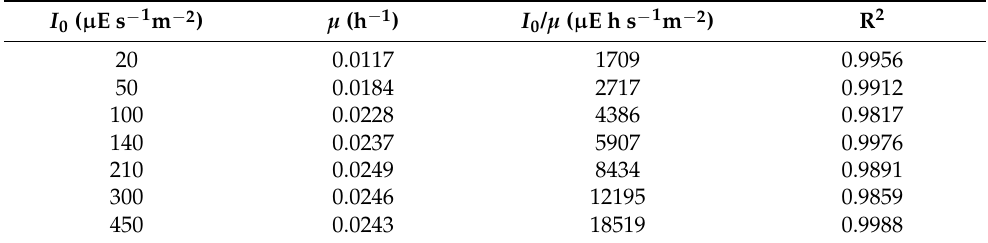
Table 1. Values of specific growth rates and R 2 calculated at different light intensities at T = 25 ◦ C in Nannochloropsis gaditana .